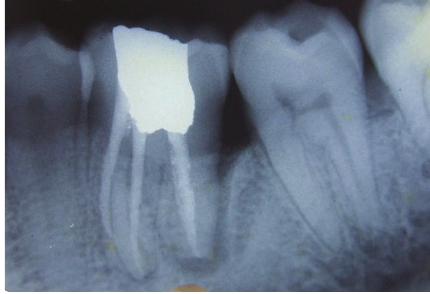
Figure 7: 1-year follow-up.